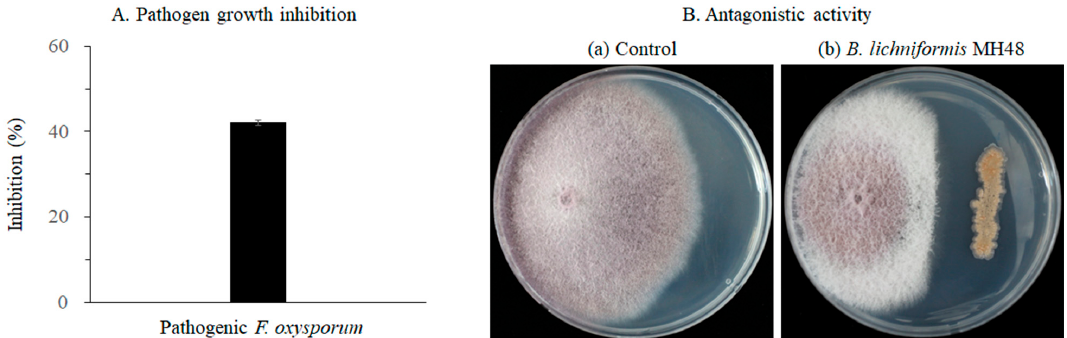
Figure 4. Growth inhibition percentage shown in a graph ( A ) and antagonistic activity shown in pictures ( B ) for control (a) and B. licheniformis MH48 (b) against F. oxysporum by culture method.